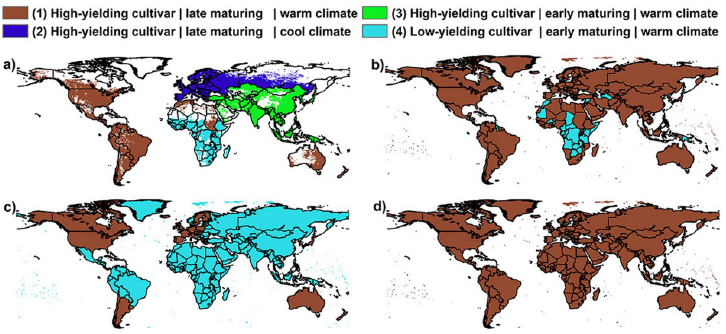
Fig 1. Distributions of maize cultivars in the EPIC-based GGCMs. (a) EPIC-IIASA, (b) EPIC-TAMU, (c) GEPIC and PEPIC, and (d) EPIC-BOKU. Differences in the parameterization of each cultivar are provided in Table D in S1 File. Numbers in parentheses (1–4) are used throughout the text to refer to the